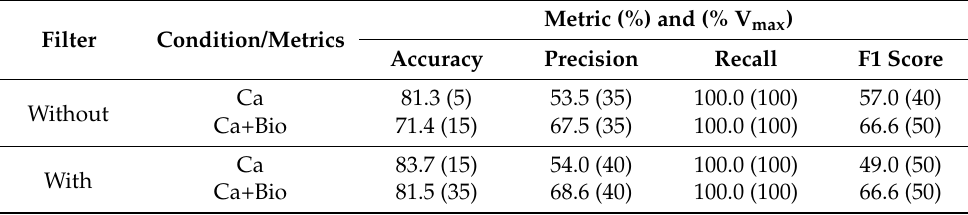
Table 3. Maximum percentages of the metrics of the confusion matrix and respective percent- ages of the maximum velocity (% V max ) obtained for zones of interest (cavity—Ca or cavity plus